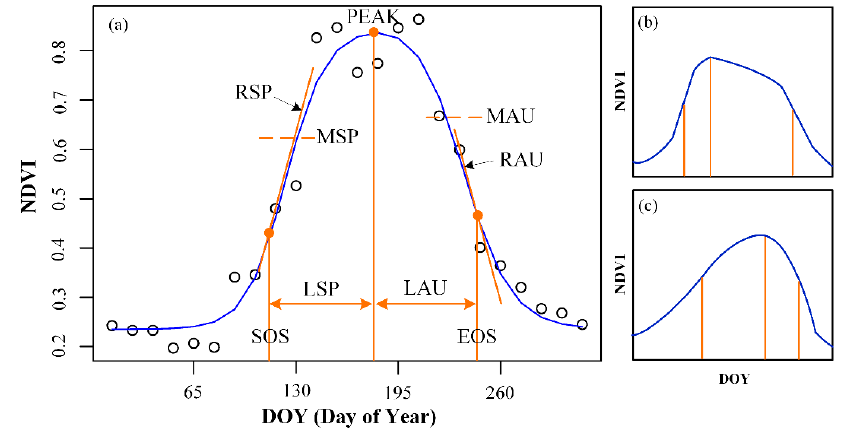
Figure 2. Conceptual illustration of vegetation growth asymmetries ( a ) symmetrical type; ( b ) rapid in and slow out; ( c ) slow in and rapid